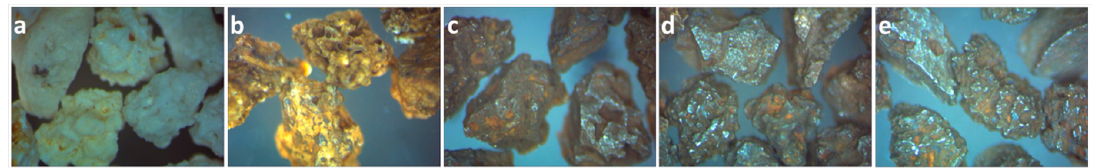
Figure 3. The changes of surface presence between raw ( a ) and once ( b ), twice ( c ), three times ( d ), and four times ( e ) coated chalcedonite (magnification 40×). Reprinted with permission from Ref. [133].